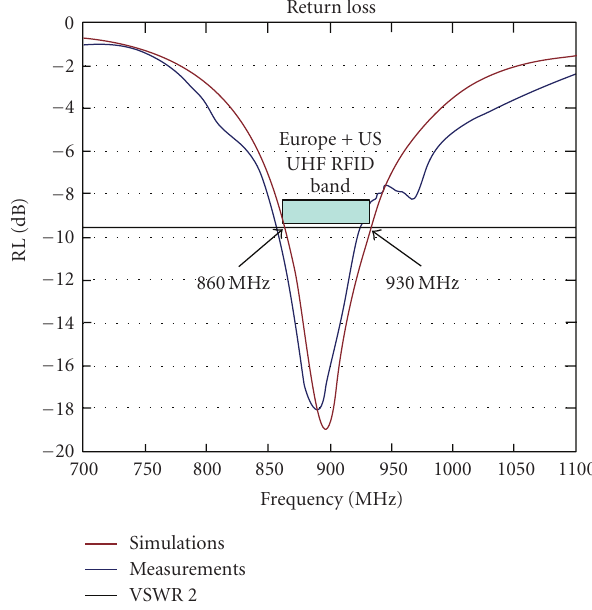
Figure 4: Return loss of the wideband RFID tag.